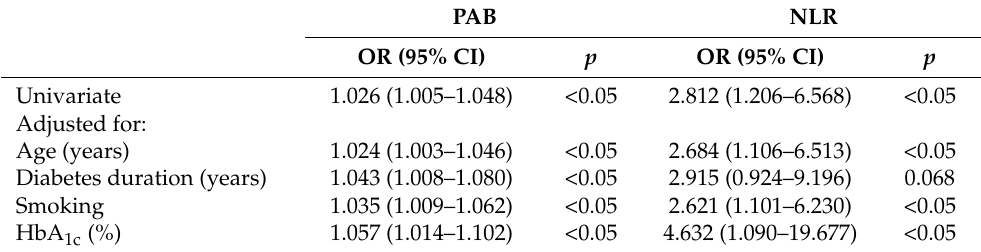
Figure 1. Biomarkers of OS in patients without DF and with DF. The levels of PAB and SOD were presented as means and standard deviations, and the levels of TOS and SHG as medians and interquartile ranges. Abbreviations: PAB, prooxidative-antioxidative balance; SOD, superoxide dismutase; TOS, total oxidative status; SHG, total sulfhydryl groups. Table 3. Logistic regression analysis for the association of PAB and NLR with